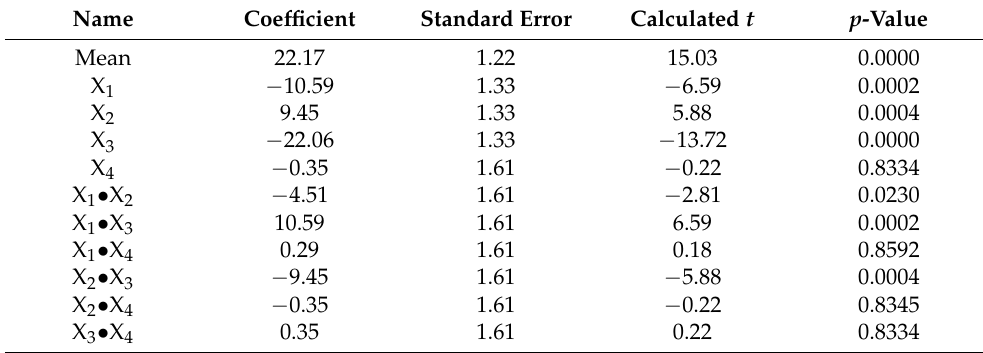
Table 4. Estimated regression coefficients and corresponding t and p values obtained during the central composite design for the RIF incorporation process in